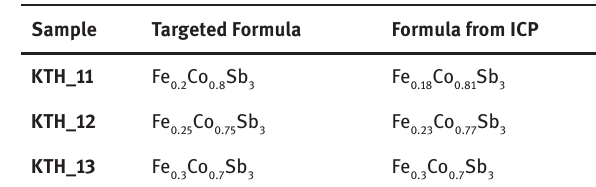
Table 1: Targeted material composition of samples with respect to precursor composition, and experimentally determined composition from ICP